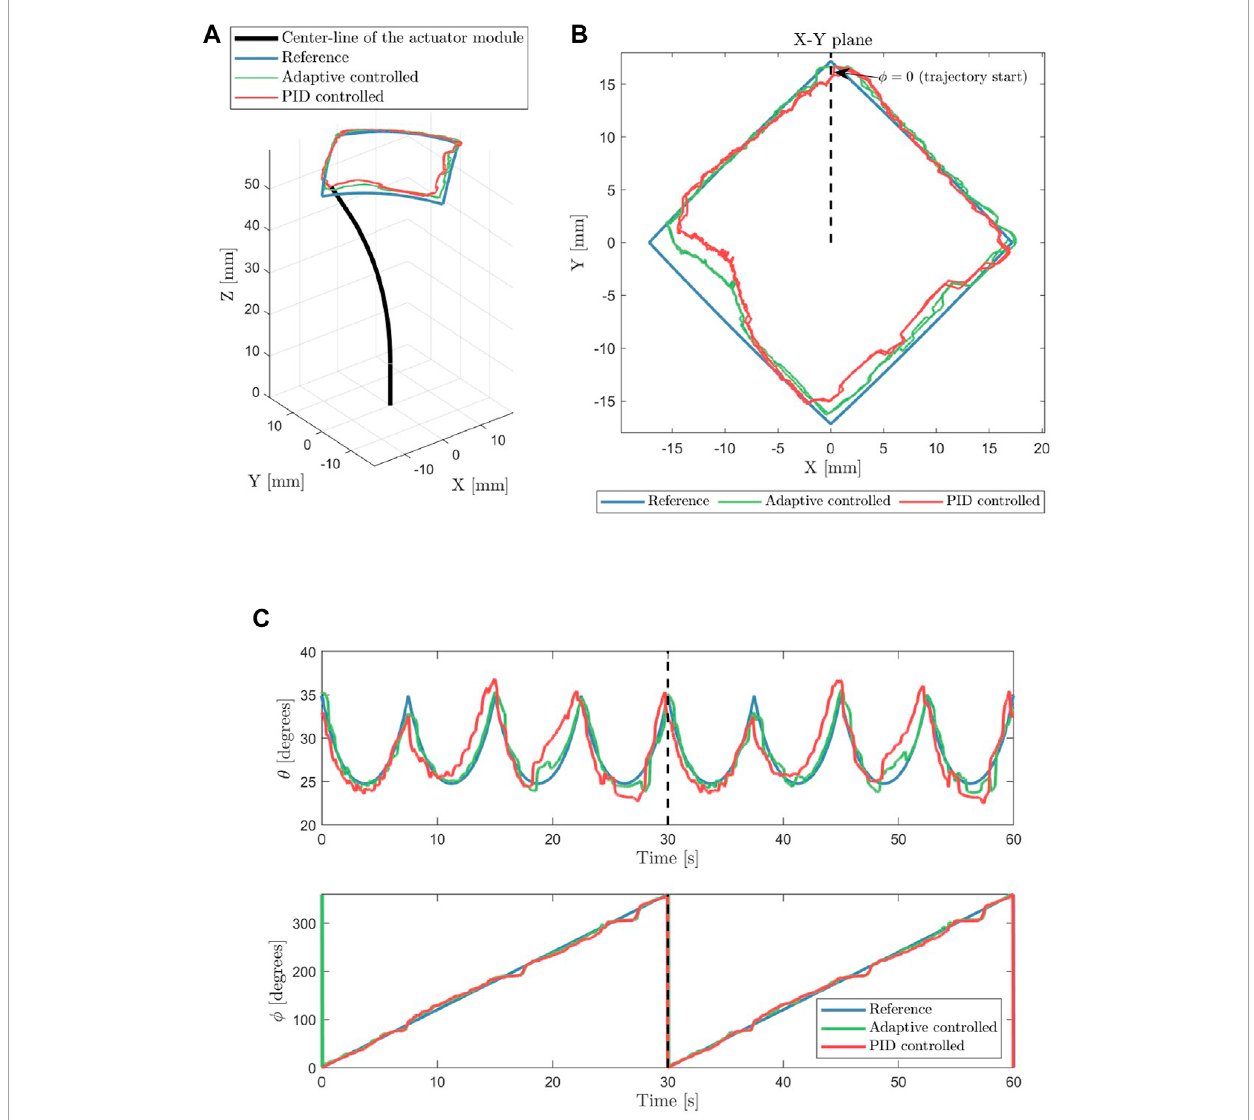
FIGURE 10 The visualization of the actuator tracking a square reference trajectory in 3D is presented in (A) , while the tip position from the top-down view is shown in (B) . The tracking results of the tip orientation angles ( θ and ϕ ) are shown in (C) . The black dashed lines indicate the start of the second lap of the square